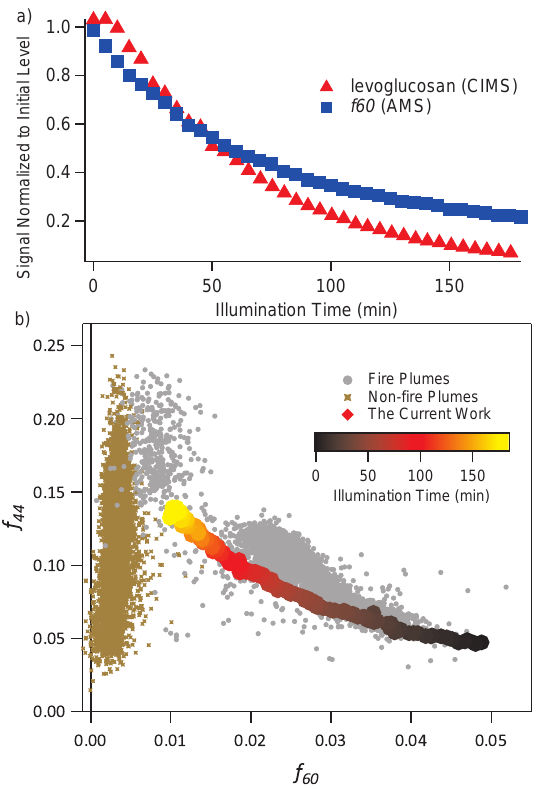
Figure 9. The time series of LG and DMSO during a kinetic exper- iment (Exp. #1 in Table 1) are shown in (a) . The signals are normal- ized to those at the beginning of the photooxidation. The relative kinetics plot from the same experiment is shown in (b) according to Eq. 1. The color code indicates the illumination time.